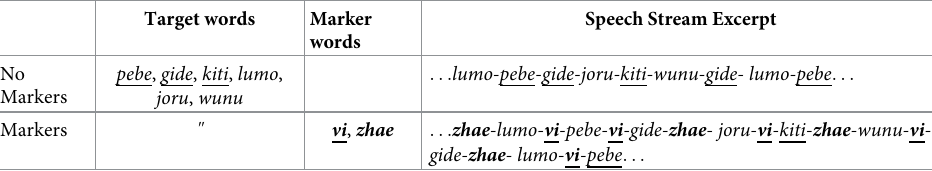
Table 5. Example speech streams for each condition in experiment 2 (with phonological